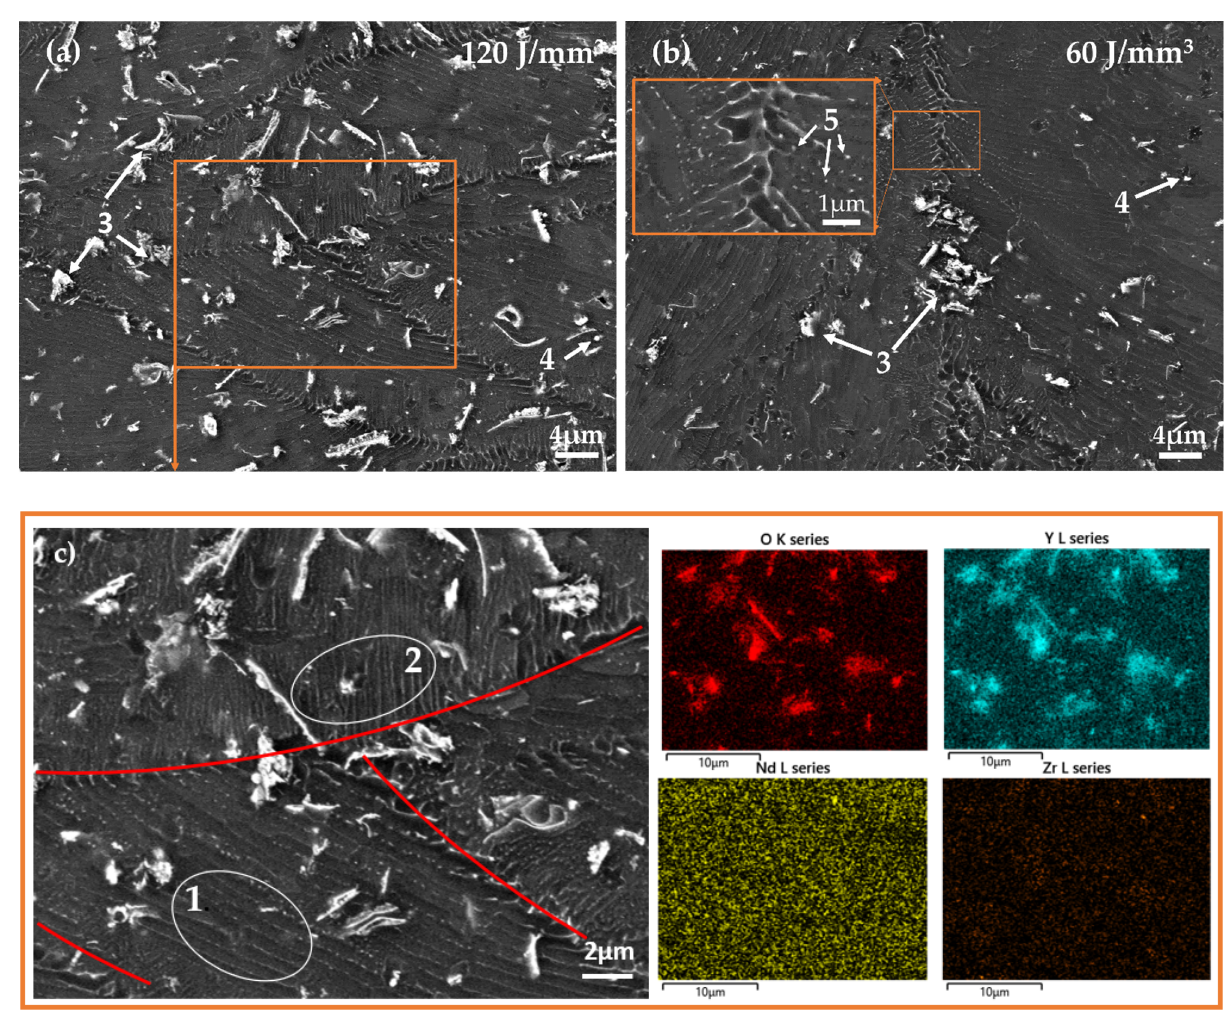
Figure 3. SEM images, where ( a ) corresponds to the samples processed with an energy density of 120 J/mm 3 and ( b ) corresponds to the samples processed with an energy density of 60 J/mm 3 . The melt pool boundaries and the columnar structure are highlighted in image ( c ), corresponding to the boxed area in ( a ). The EDS maps correspond to the same area. Nr 1 and 2 highlights the orientation of the columnar structure observed in different parts of the melting pool. Nr 3 corresponds to areas rich in Y and O, and 4 to particles rich in Zr. Nr 5 are precipitates at the boundaries of the columnar structures.